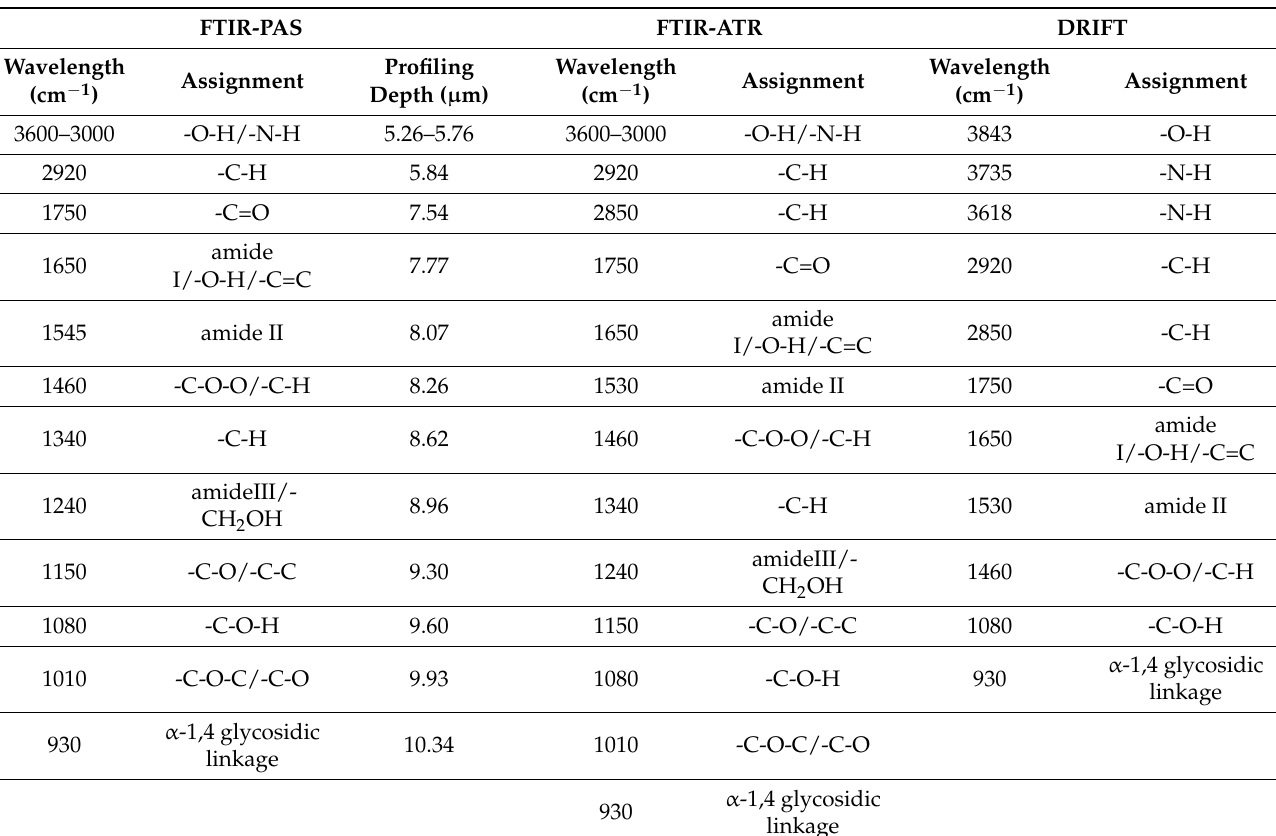
Table 1. Assignment of the main bands of the FTIR spectra of the rice samples.